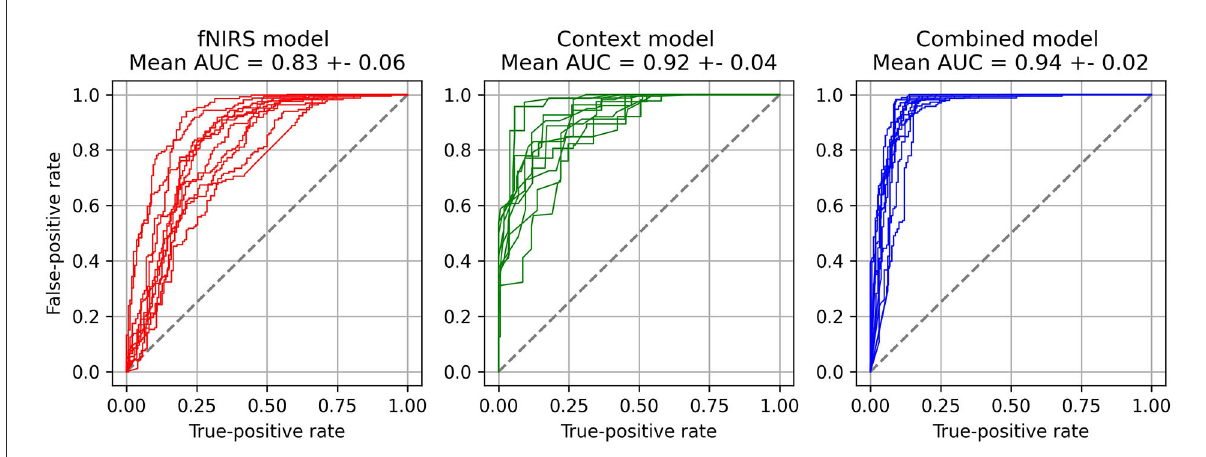
FIGURE6 ROC curves for each of the three models and each of the subjects.